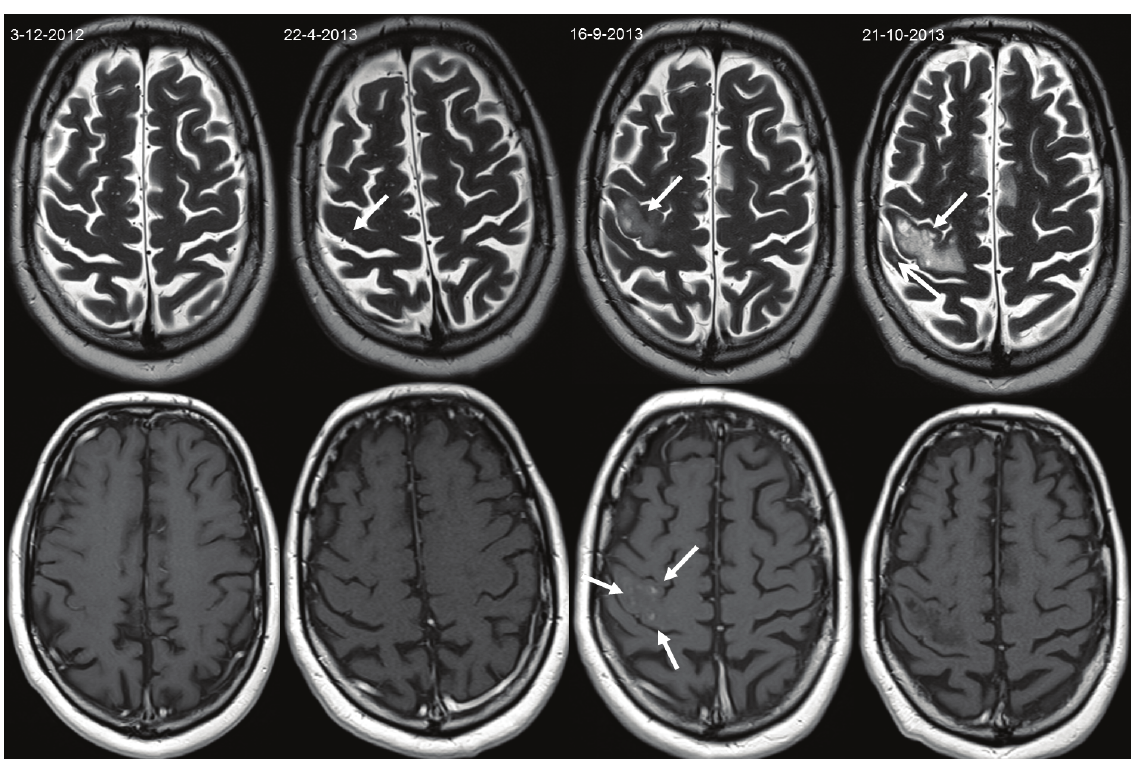
Figure 1: Axial T2-weighted (top row) and contrast-enhanced T1-weighted images (bottom row) obtained during Natalizumab treatment (3 December 2012), at the time of Natalizumab discontinuation (22 April 2013), at the time of PML-IRIS occurrence (16 September 2013), and after PML-IRIS treatment (21 October 2013). A small lesion suggestive of PML was already visible at the time of Natalizumab discontinuation (arrow). During Fingolimod treatment, this lesion progressed and changed to a PML-IRIS manifestation with slight mass effect and contrast enhancement (arrows) leading to posttreatment sequelae (arrow).